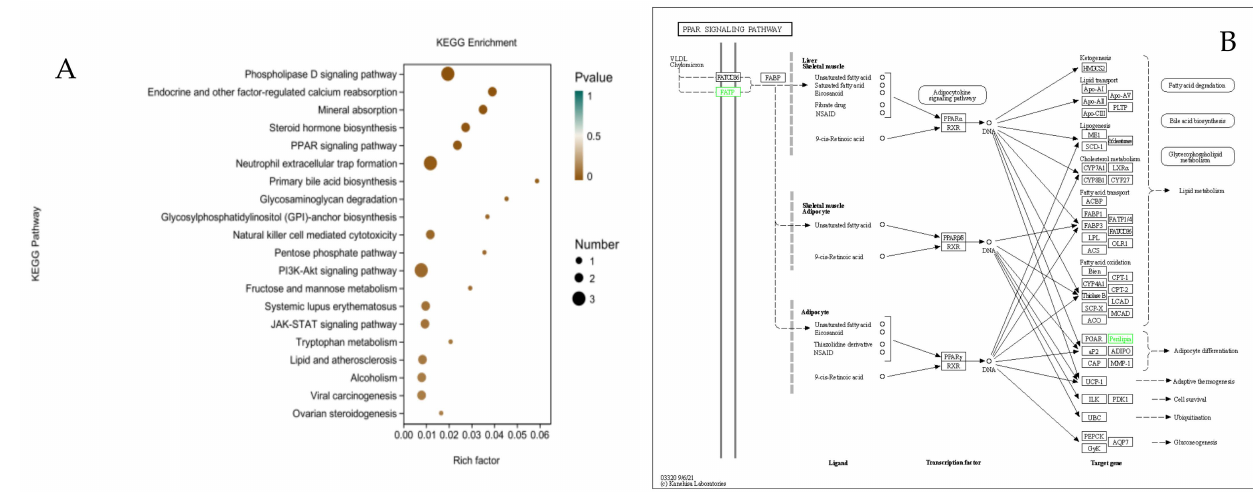
Figure 10. KEGG enrichment analysis of differentially expressed genes (DEGs) after interference of DGAT2. ( A ) KEGG enrichment factor map. ( B ) KEGG functional annotation of DEGs involved in the PPAR signaling pathway. Green rectangles indicate that DEGs were significantly downregulated (log fold change > 1, FDR < 0.001) in BSCs infected with sh-DGAT2 compared to control